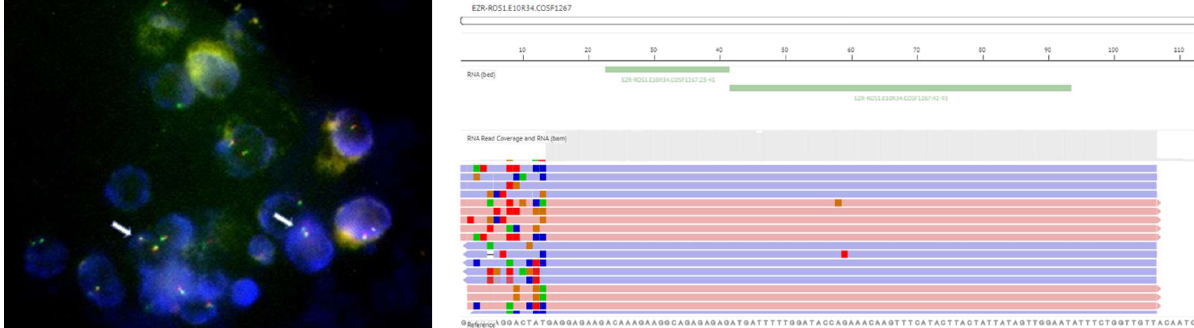
Figure 1. Image of FISH assay detecting ROS1 rearrangements (indicated by arrows) and image of NGS RNA panel (Oncomine Dx) detecting EZR–ROS1 fusion. Both tests were performed at our Molecular Pathology Laboratory on cytoblock specimen from pleural effusion in a 55-year-old woman (non-smoker) diagnosed with advanced adenocarcinoma of the lung. In this particular case, IHC screening was positive, but FISH assay was positive for rearrangement only on 8% of cells, not meeting the positivity threshold ( ≥ 15%), but fusion was then confirmed by NGS testing. Patient gave her informed consent to publish images and her clinical information.